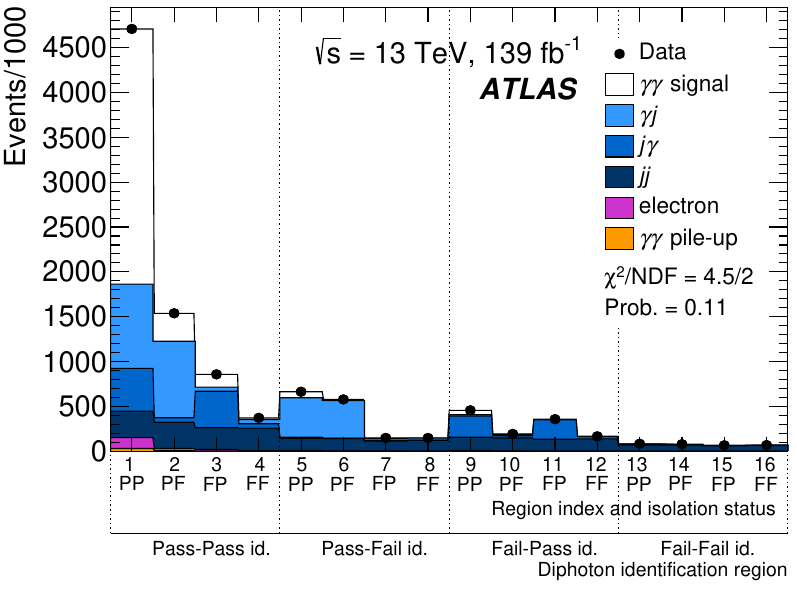
Figure 4. Event yields of the inclusive data sample in the 16 diphoton regions. Both the observed counts and the fit result, including the estimated contributions from the signal and each background component, are shown. The quoted χ 2 value is computed taking into account the systematic uncertainties of the fit model, and their correlation between bins. Labels ‘PP/PF/FP/FF’ are used to denote the isolation status (‘P’ = pass, ‘F’ = fail) of the leading and sub-leading photon candidates. Similarly, the labels ‘Pass-Pass id.’, ‘Pass-Fail id.’, etc., denote the identification status of the two photon